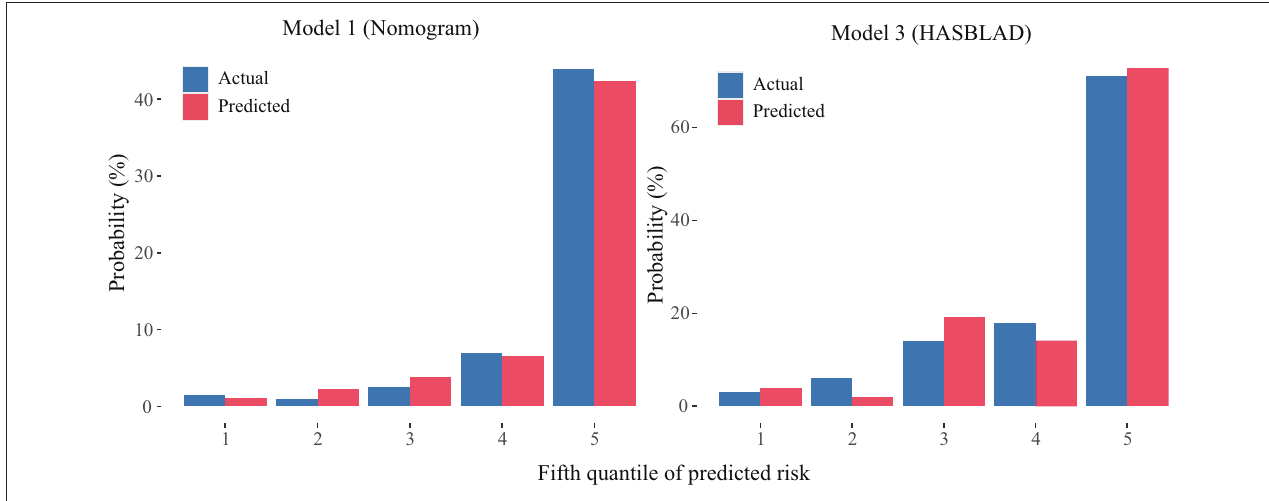
FIGURE 7 | Calibration curves of the Model 1 and the Model 3 in the validation set. The left plot was the calibration curve of the Model 1 (Nomogram) in the validation set. The right plot was the calibration curve of the Model 3 (HASBLAD) in the validation set.